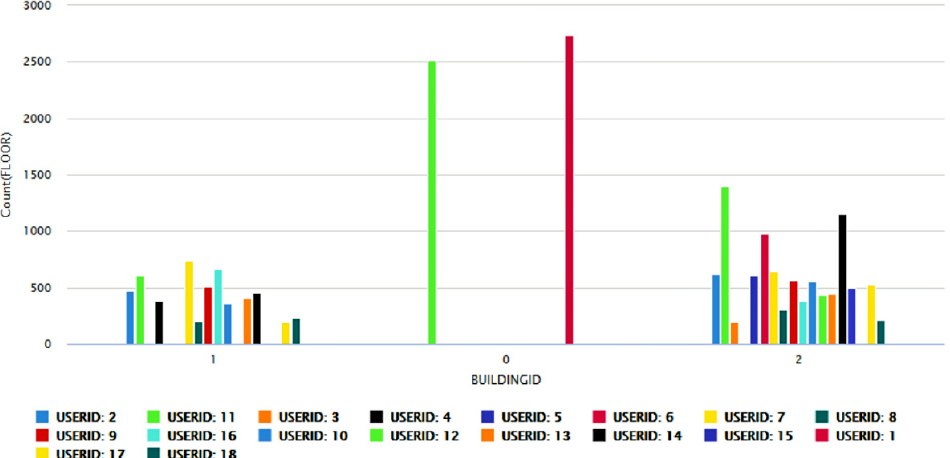
Figure 4. A bar plot representing the number of times the different users were present on a floor (all the floors taken together) in the different buildings, where the plot is grouped by the value of the attribute—BuildingID.